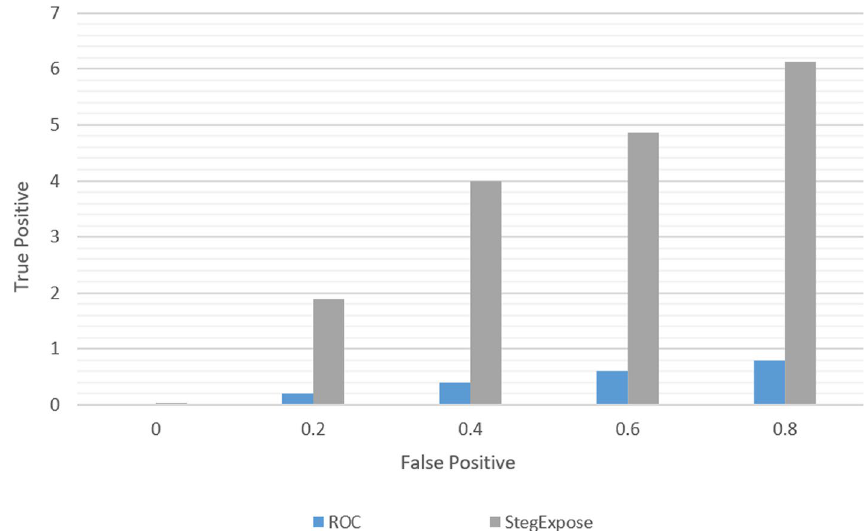
Fig. 18 When using the proposed steganography analysis to identify hidden images, the rate comparison between (False Positive Rate) and (True Positive Rate)